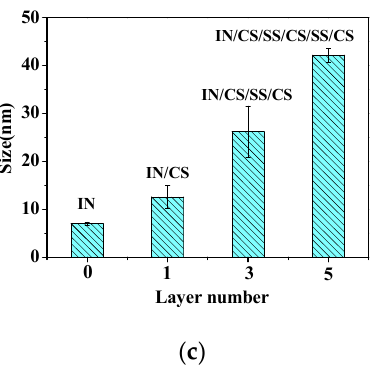
Figure 1. Zeta − potentials of shell materials ( a ) and multi − layer nanocapsules ( b ), and size of multi − layer nanocapsules ( c ). Abbreviations: IN, insulin; CS, carboxymethyl anionic starch; and SS, spermine cationic starch.